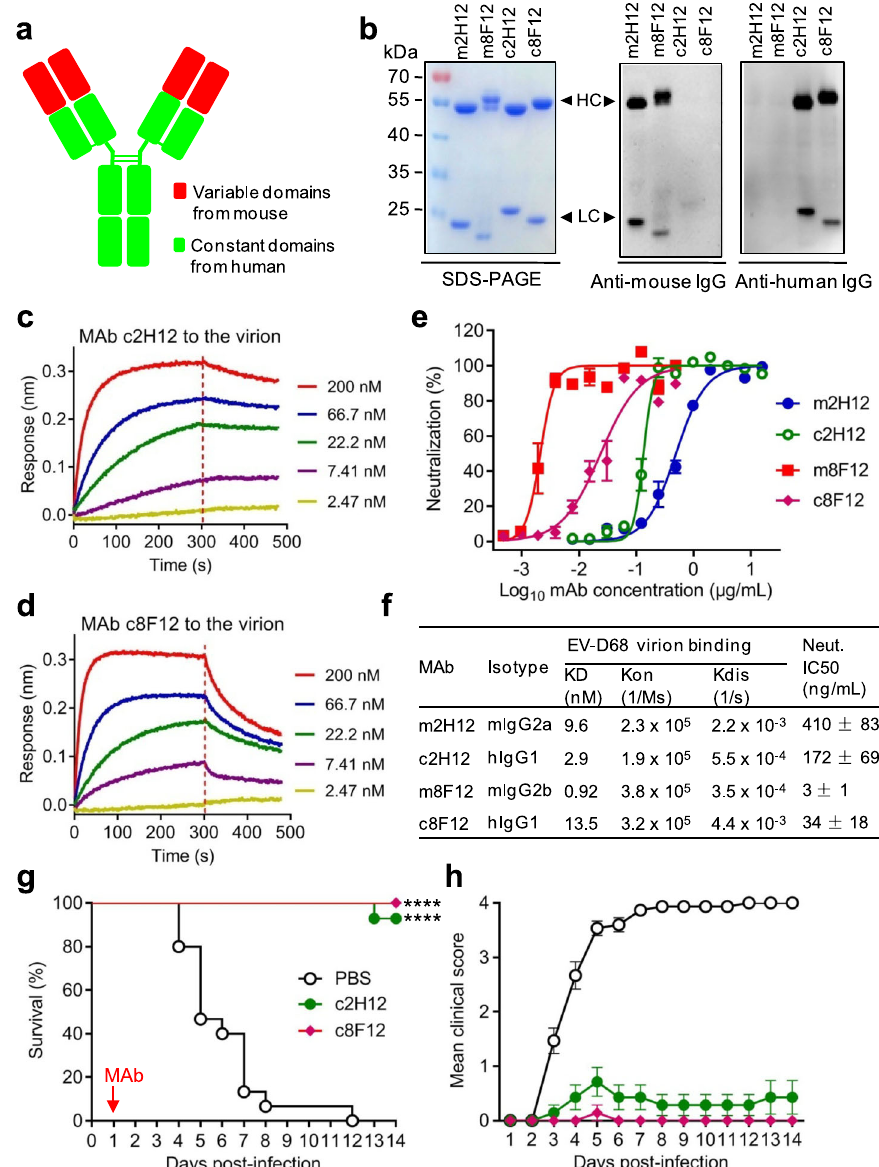
Fig. 7 Binding af fi nities, neutralization activities and therapeutic ef fi cacy of the chimeric MAbs. a Schematic of chimeric MAb. Mouse variable domains are shown as red boxes, while human constant domains are shown as green boxes. b SDS-PAGE and western blotting analysis of the puri fi ed MAbs. Lane M, protein marker; m2H12, murine MAb 2H12; m8F12, murine MAb 8F12; c2H12, chimeric MAb 2H12; c8F12, chimeric MAb 8F12. Anti-human IgG or